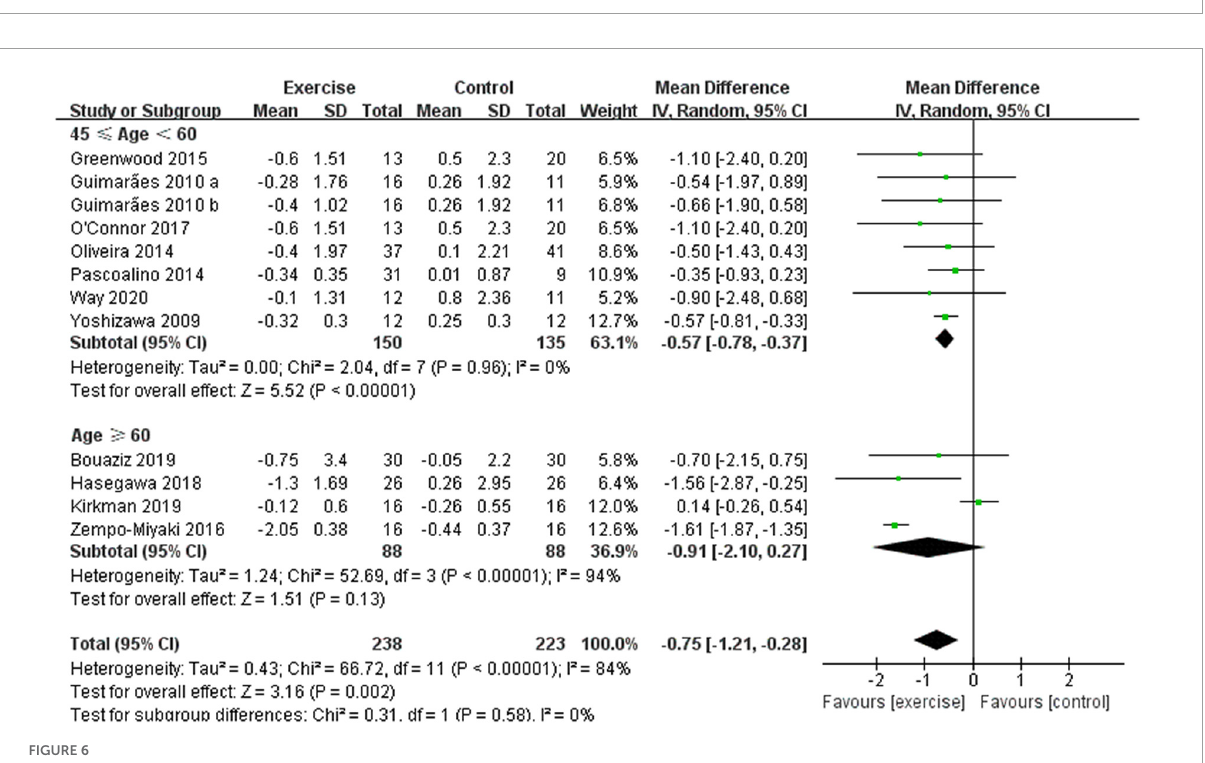
FIGURE6 Meta-analysis results of the effect of aerobic exercise on the PWV of middle-aged people or elderly people. The pooled estimates were obtained from random effects analysis. Diamonds indicate the size of the effect of each study summarized as WMD. The size of the shaded square is proportional to the percentage weight of each study. Horizontal line represents the 95% CI and the vertical dashed line represents the overall